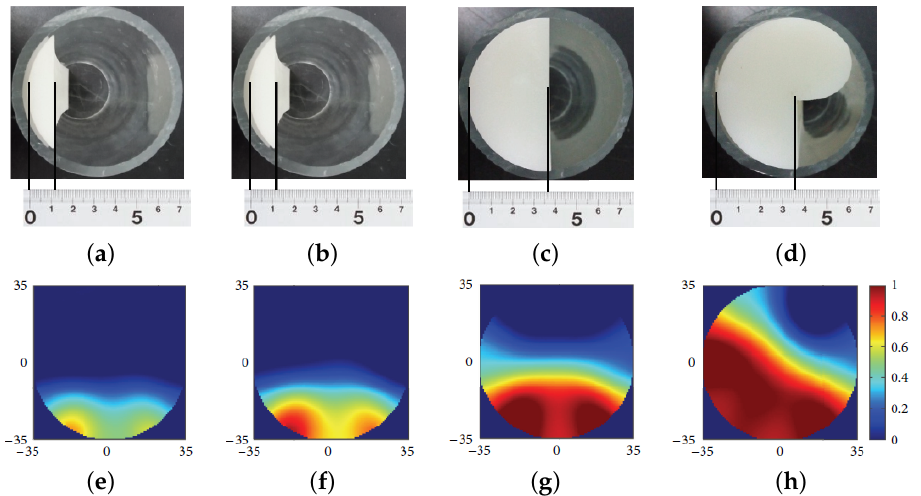
Figure 41. Actual wax model for deposits of ( a ) concentration = 11%, ( b ) concentration = 18.5%, ( c ) concentration = 52.5%, and ( d ) concentration = 62.5%. Reconstructed image for deposit ( e ) concen- tration = 11%, ( f ) cncentration = 18.5%, ( g ) concentration = 52.5%, and ( h ) concentration = 62.5%. Reprinted under Creative Commons CC BY license